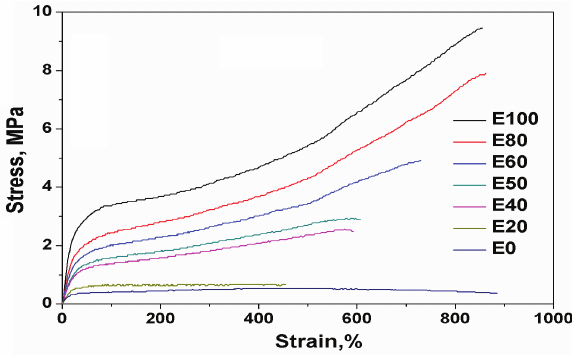
Figure 4: Strain-strain plot of pristine EMA, NBR and their various blends.